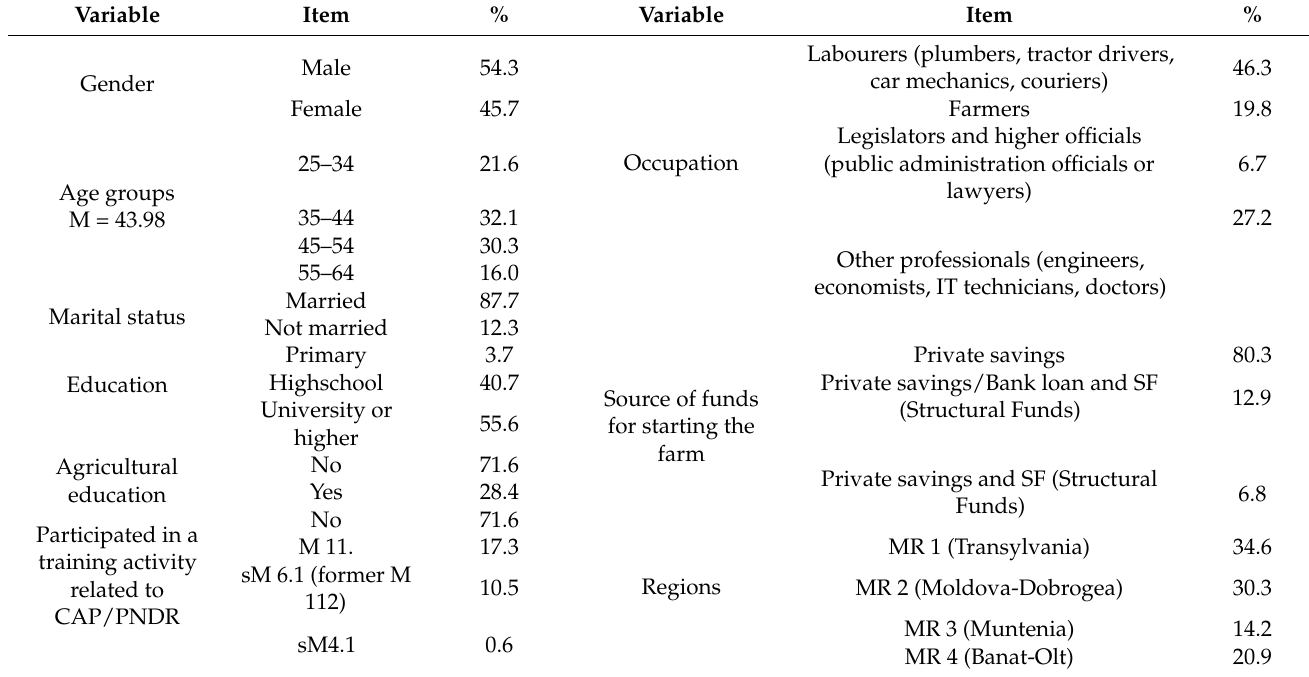
Table 3. Socio-demographic profiles of farms owners (small